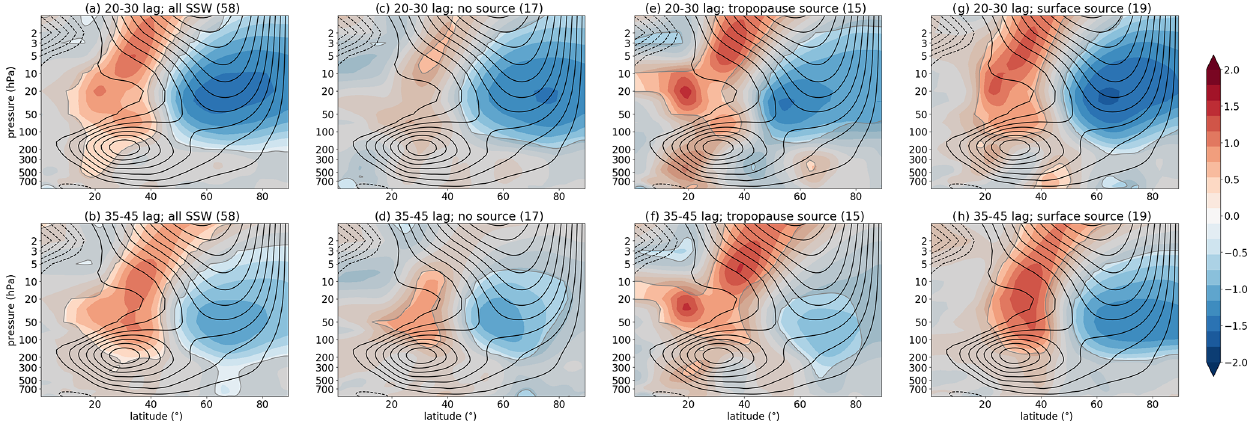
Figure 9. As in Fig. 8 but for ERA-20C data. Here composites are shown for zonal mean zonal wind (latitude–pressure vertical cross section) averaged between the lags of 20 and 30d (a, c, e, g) and 35 and 45d (b, d, f, h) following (a, b) all SSW events, (c, d) SSWs not preceded by any wave-source events, (e, f) SSWs preceded by tropopause wave source, and (g, h) SSWs preceded by a surface wave